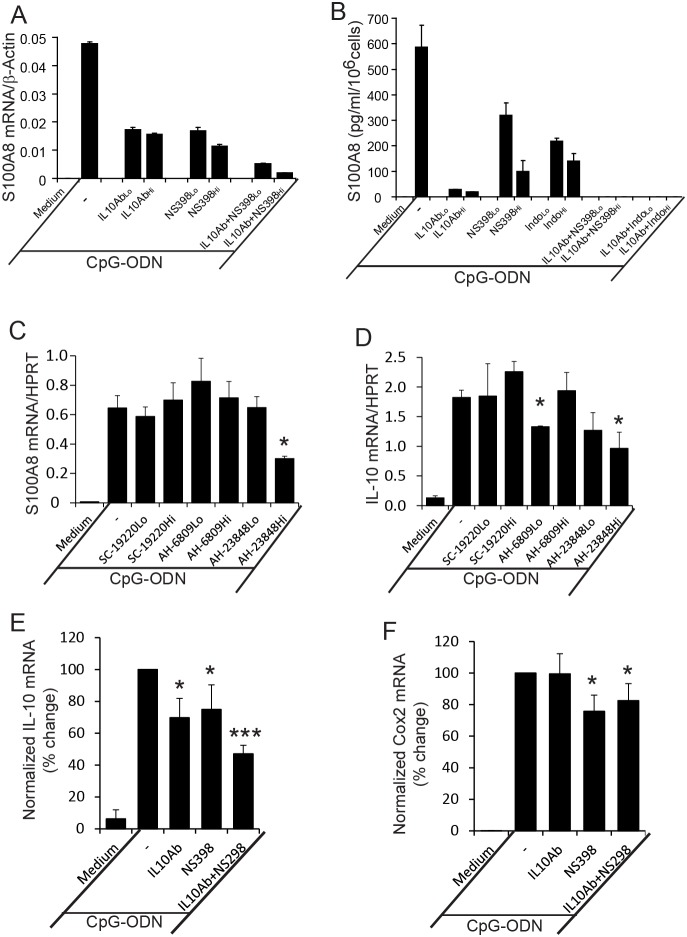
Induction of S100A8 in macrophages by CpG-ODN requires both IL-10 and PGE2/EP4 dual signaling pathways.(A and B) RAW cells were incubated with CpG-ODN (3 µM) for 20 h in the presence/absence of two doses (Lo: low, 1 ng/ml; Hi: high, 10 ng/ml) of IL-10 Ab and/or COX inhibitors (NS389: Lo, 5 µM, Hi, 50 µM; Indomethacin (Indo): Lo, 2 µM; Hi, 20 µM). Cells and supernates were harvested, and S100A8 mRNA (A) or protein (B) quantitated. Data represent means ± SD of duplicates and representative of 3 experiments. (C and D) RAW cells were incubated with CpG-ODN (3 µM) in the presence/absence of two doses (Lo, 1 µM; Hi, 10 µM) of antagonists for EP1 (SC-19220), EP2 (AH-6809), and EP4 (AH-23848) for 8 (C) and 20 h (D). IL-10 (C) and S100A8 mRNA (D) quantitated by qRT-PCR. (E and F) RAW cells were untreated or treated with CpG-ODN (3 µM) for 6 h in the presence/absence of anti-IL-10 Ab (5 ng/ml) and/or NS389 (25 µM), and IL-10 (E) and Cox2 (F) mRNA quantitated by qRT-PCR, For C–F, data represent means ± SD of −5 separate experiments. *P<0.05, ***P<0.001 of differences between samples treated with CpG-ODN alone and CpG-ODN plus various inhibitors.